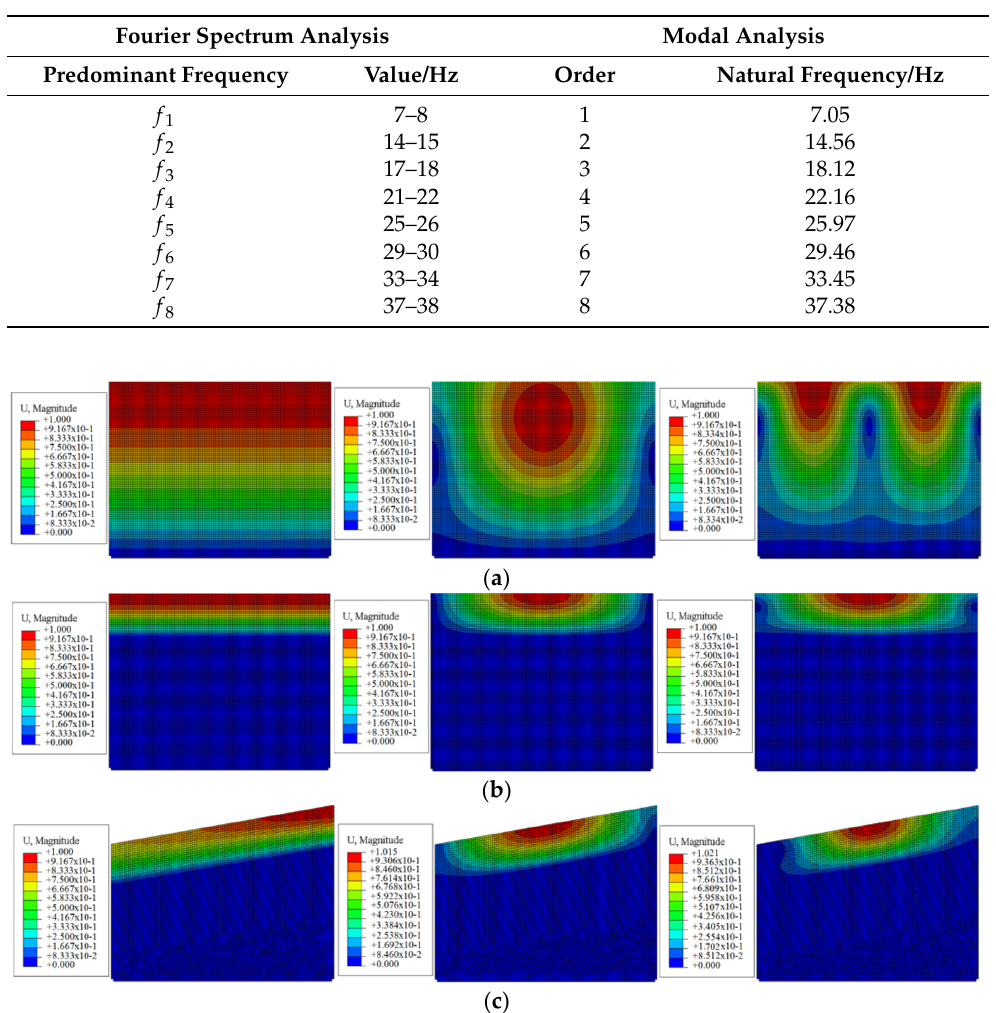
Figure 13. First three vibration modes of the models: ( a ) Model 1, ( b ) Model 2, ( c ) Model 3. Modes 1–3 are shown from left to the right.